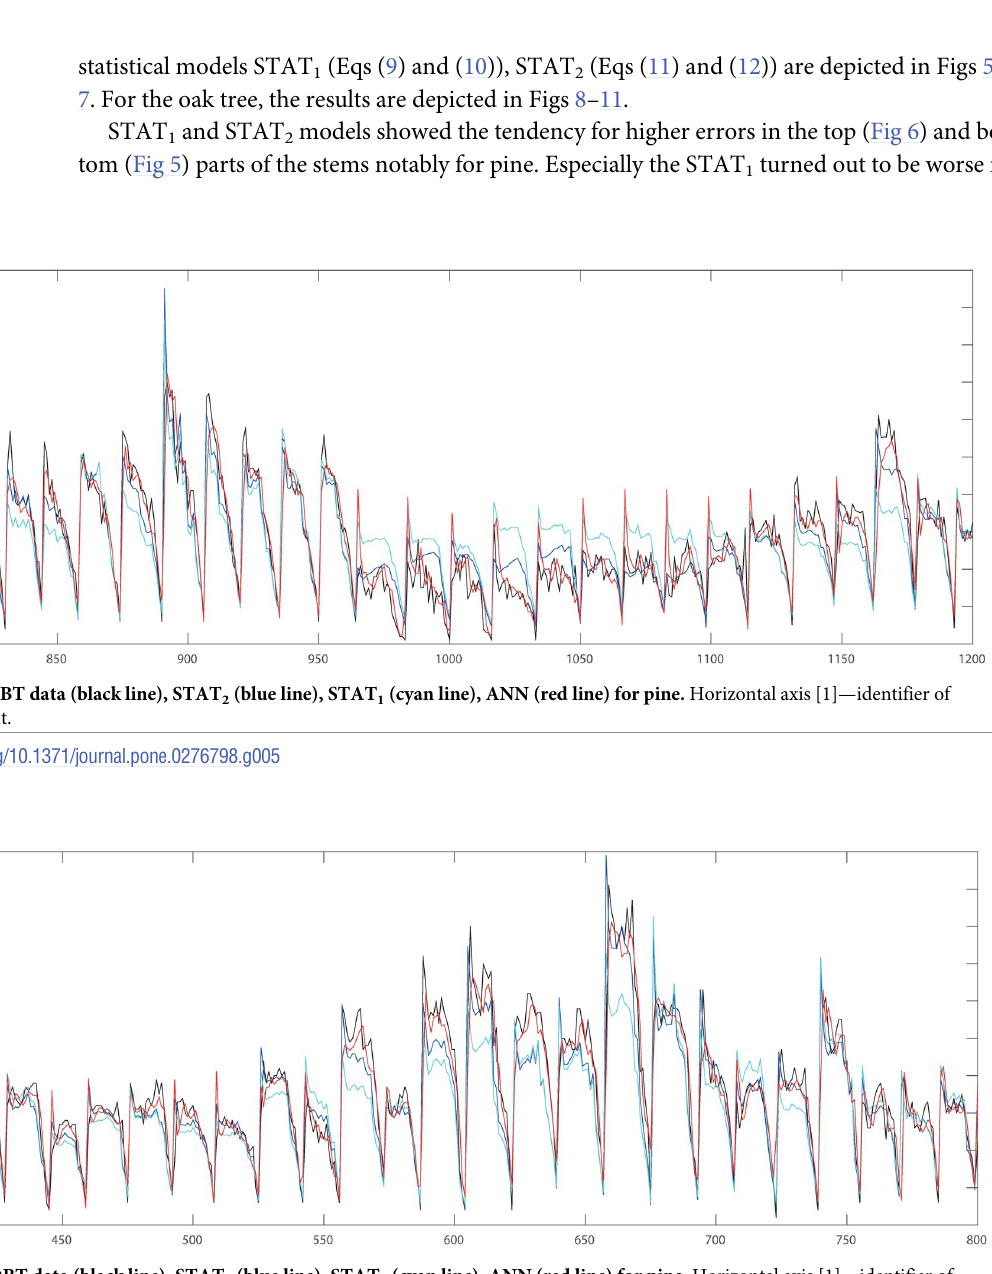
Fig 6. 150 DBT data (black line), STAT 2 (blue line), STAT 1 (cyan line), ANN (red line) for pine. Horizontal axis [1]—identifier of measurement.